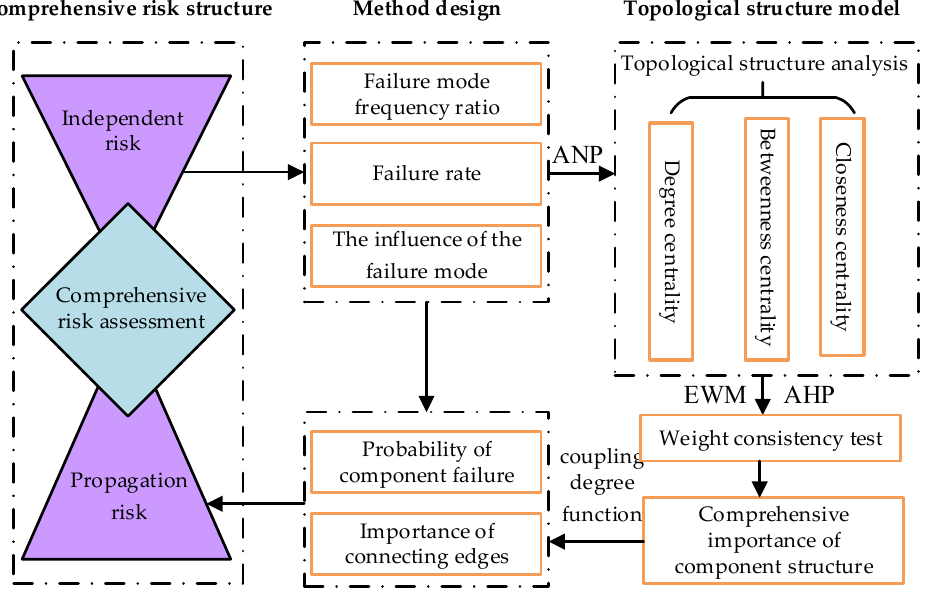
Figure 1. Comprehensive failure risk assessment framework diagram of machining center component.